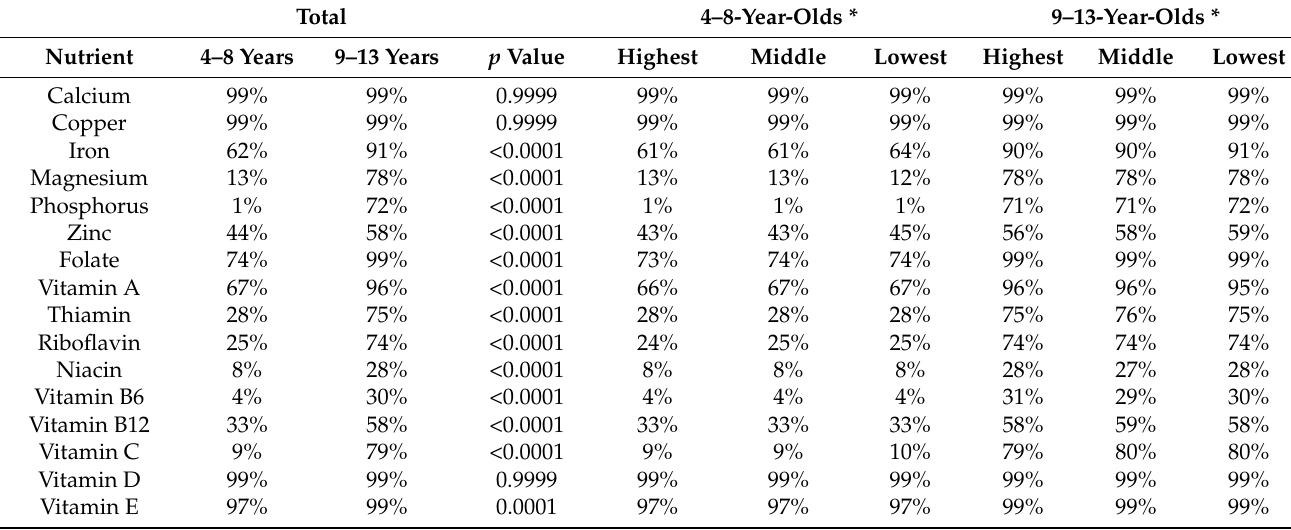
Table 4. Percentage of micronutrient intakes below the EAR among 4–8 and 9–13-year-old Nigerian children across socio-economic